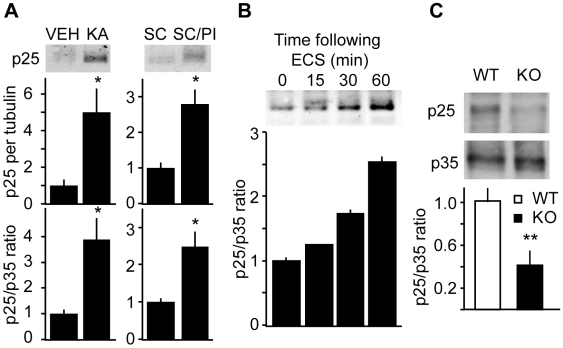
p25 generation in the hippocampus after pharmacologically-induced status epilepticus and electroconvulsive shock.
A, Representative immunoblots (top) and quantitation of p25 per tubulin (middle) and p25/35 ratio (bottom) after treatment with kainate and pilocarpine. VEH = saline; KA = kainate (50 mg/kg); SC = scopolamine (2 mg/kg)/saline; and SC/PI = scopolamine (2 mg/kg)/pilocarpine (280 mg/kg). n = 4; *P<0.05 vs. VEH and SC in; Student's t-test. B, Representative immunoblots of p25 and quantitation of p25/p35 ratio 15, 30, and 60 min following electroconvulsive shock administration compared to unshocked controls (time = 0); n = 2. C, Hippocampal p25∶p35 ratio 6–8 weeks post-KO. Crude lysates were immunoblotted for p25 and p35. Double asterisk indicates P<0.05 versus aged WT, Student's t-test; n = 3–4. Data represent means±s.e.m.